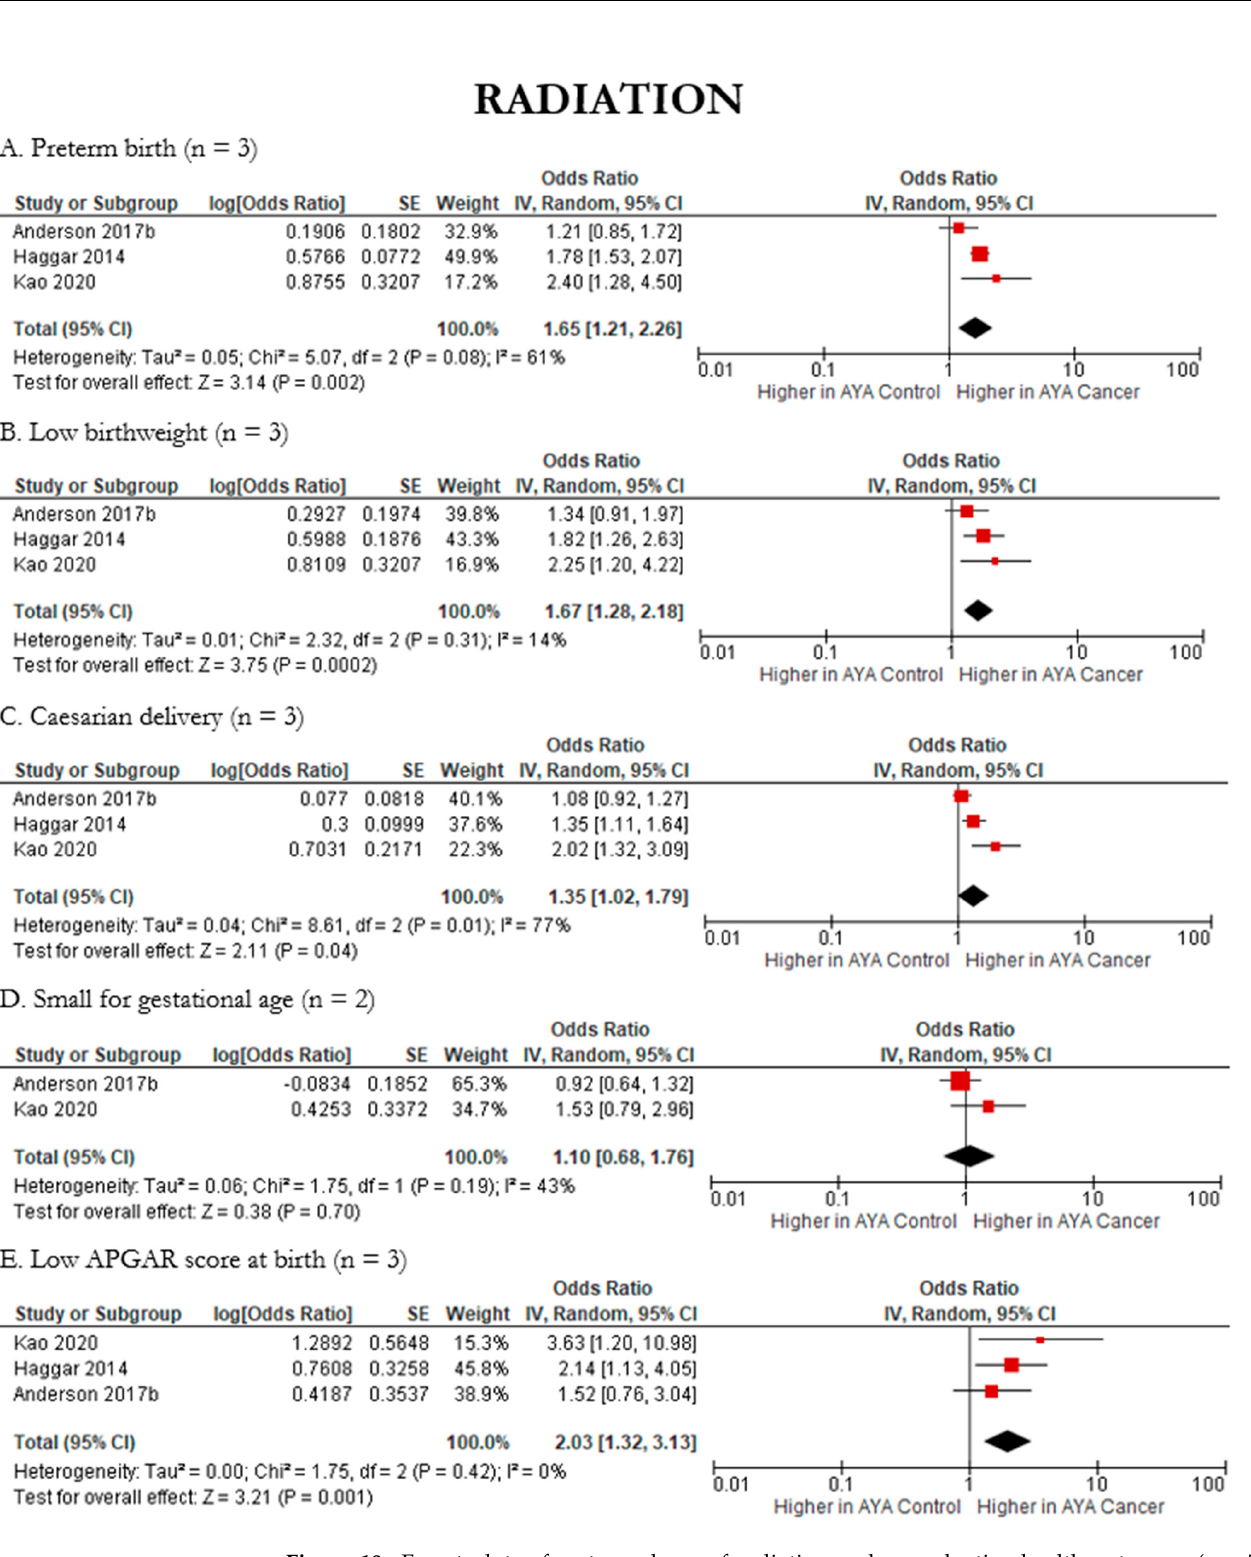
Figure 10. Forest plots of meta-analyses of radiation and reproductive health outcomes (n = 5). A.